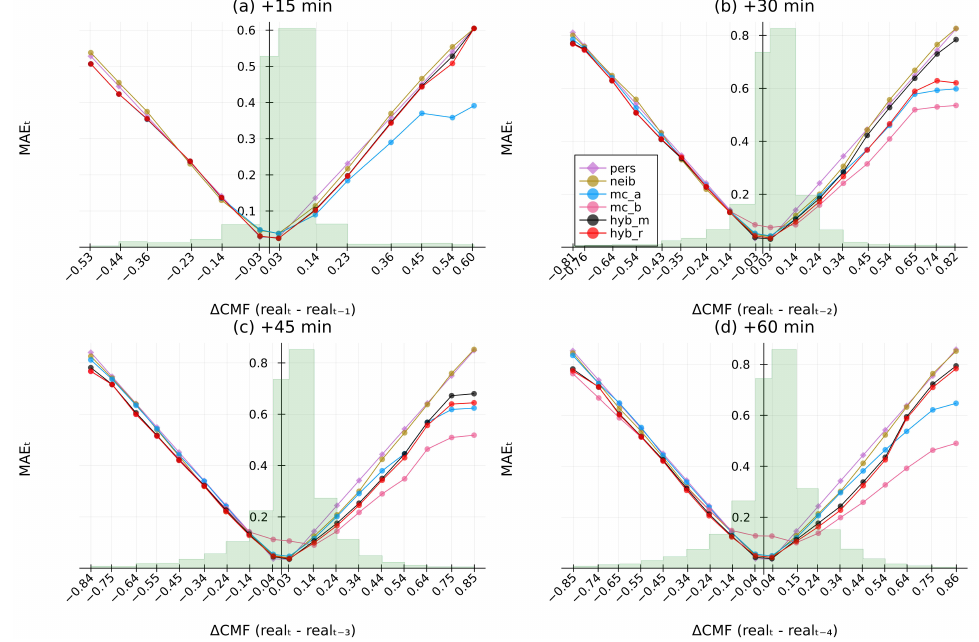
Figure 12. MAE of CMF change for ( a ) 15 min, ( b ) 30 min, ( c ) 45 min, and ( d ) 60 min ahead for Berlin. The horizontal ticks are the means of every class of CMF change, where the change classes are equally spaced with an interval of 0.1, e.g., [ − 0.1, 0) and [0, 0.1). The results for the other three cities can be found in Figures A7–A9 in Appendix A.